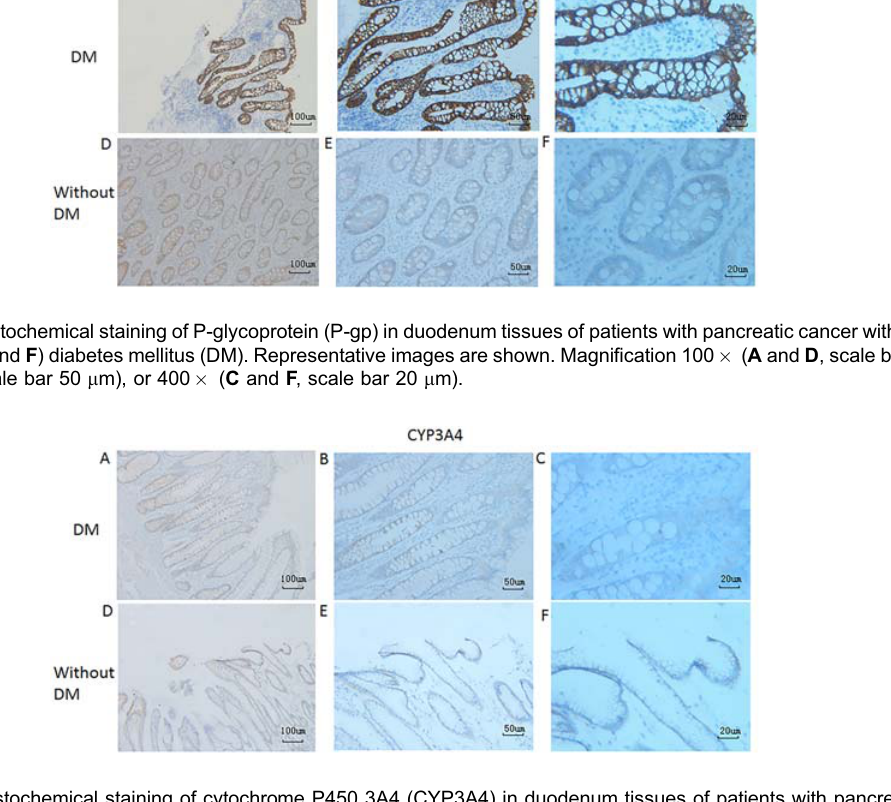
Figure 3. Immunohistochemical staining of cytochrome P450 3A4 (CYP3A4) in duodenum tissues of patients with pancreatic cancer with ( A , B , and C ) or without ( D , E , and F ) diabetes mellitus (DM). Representative images are shown. Magni fi cation 100 (cid:1) ( A and D , scale bar 100 m m), 200 (cid:1) ( B and E , scale bar 50 m m), or 400 (cid:1) ( C and F , scale bar 20 m